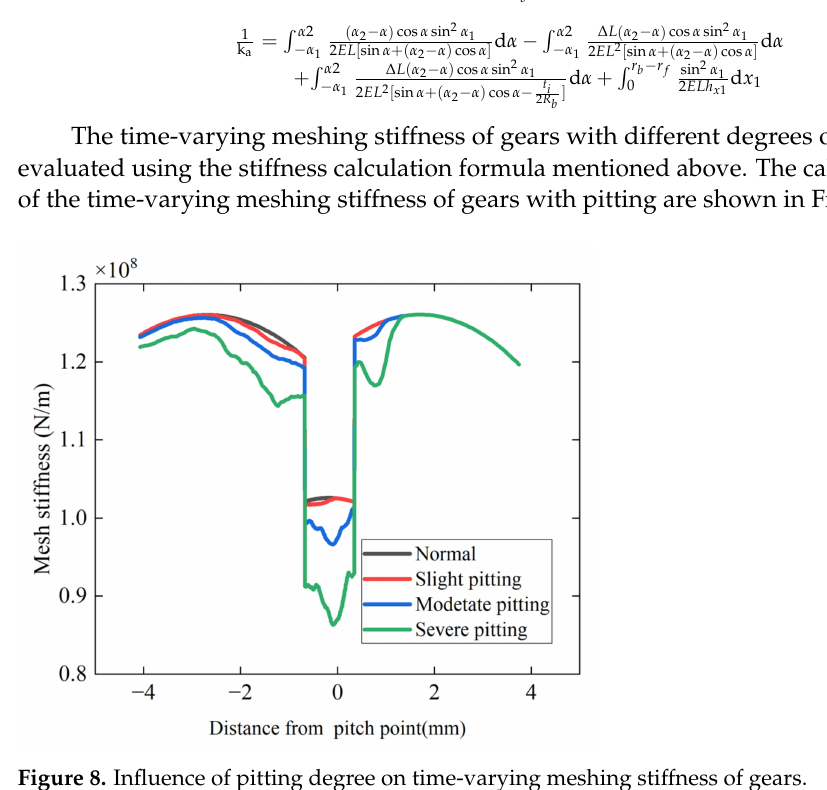
Figure 8. Influence of pitting degree on time-varying meshing stiffness of